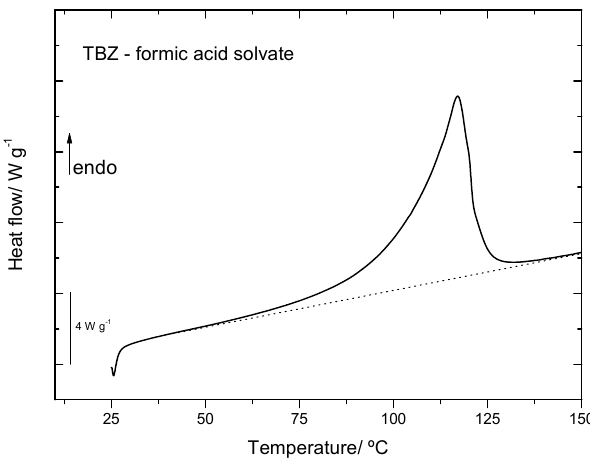
Figure 14. DSC heating curve of TBZ–formic acid solvate, from 25 °C to 150 °C, at a rate of 10 °C per minute.